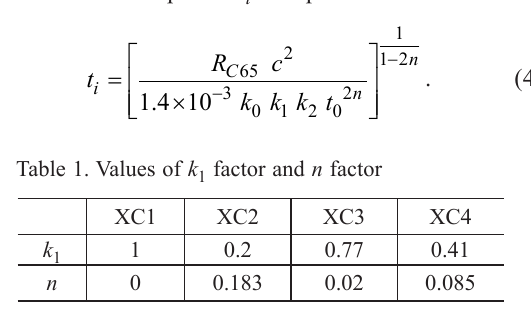
Table 3. Minimum propagation periods from corrosion